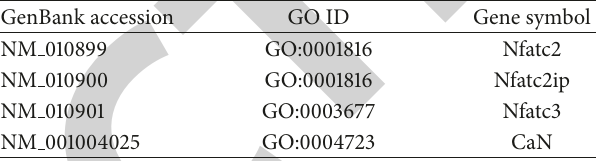
Table 5: Immune related genes covered in GO and